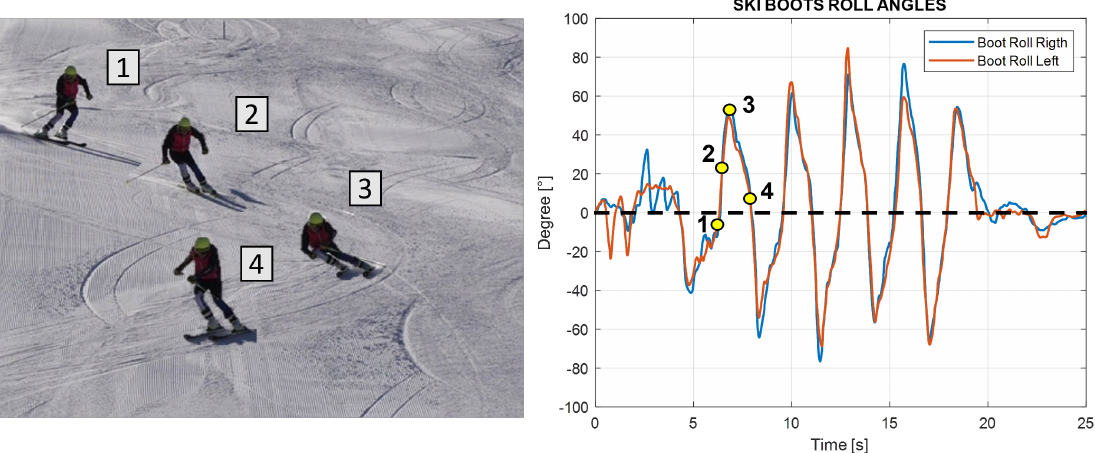
Figure 7. Highlight of one turn in the roll angle